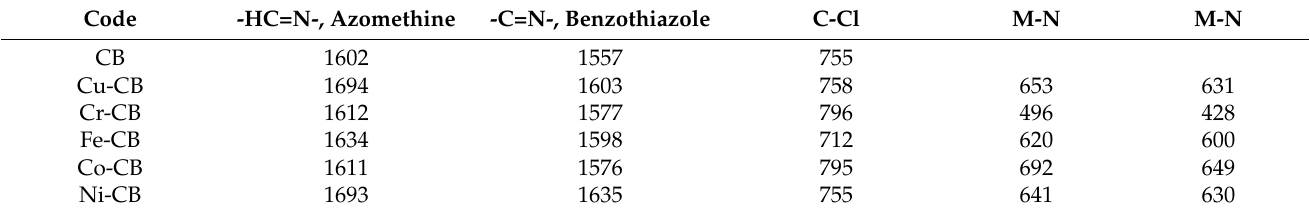
Table 3. FTIR main stretching absorption bands (cm − 1 ) of CB and its metal complexes.